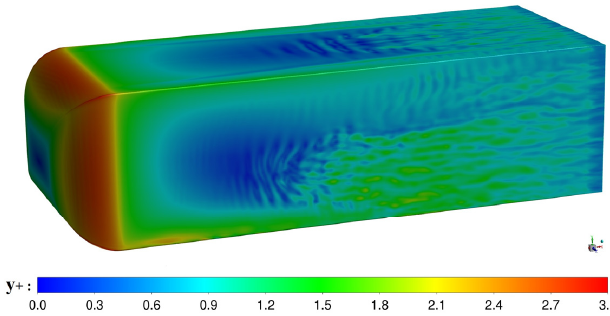
Figure 3. Computational mesh. ( a ) Block structure; ( b ) mesh.